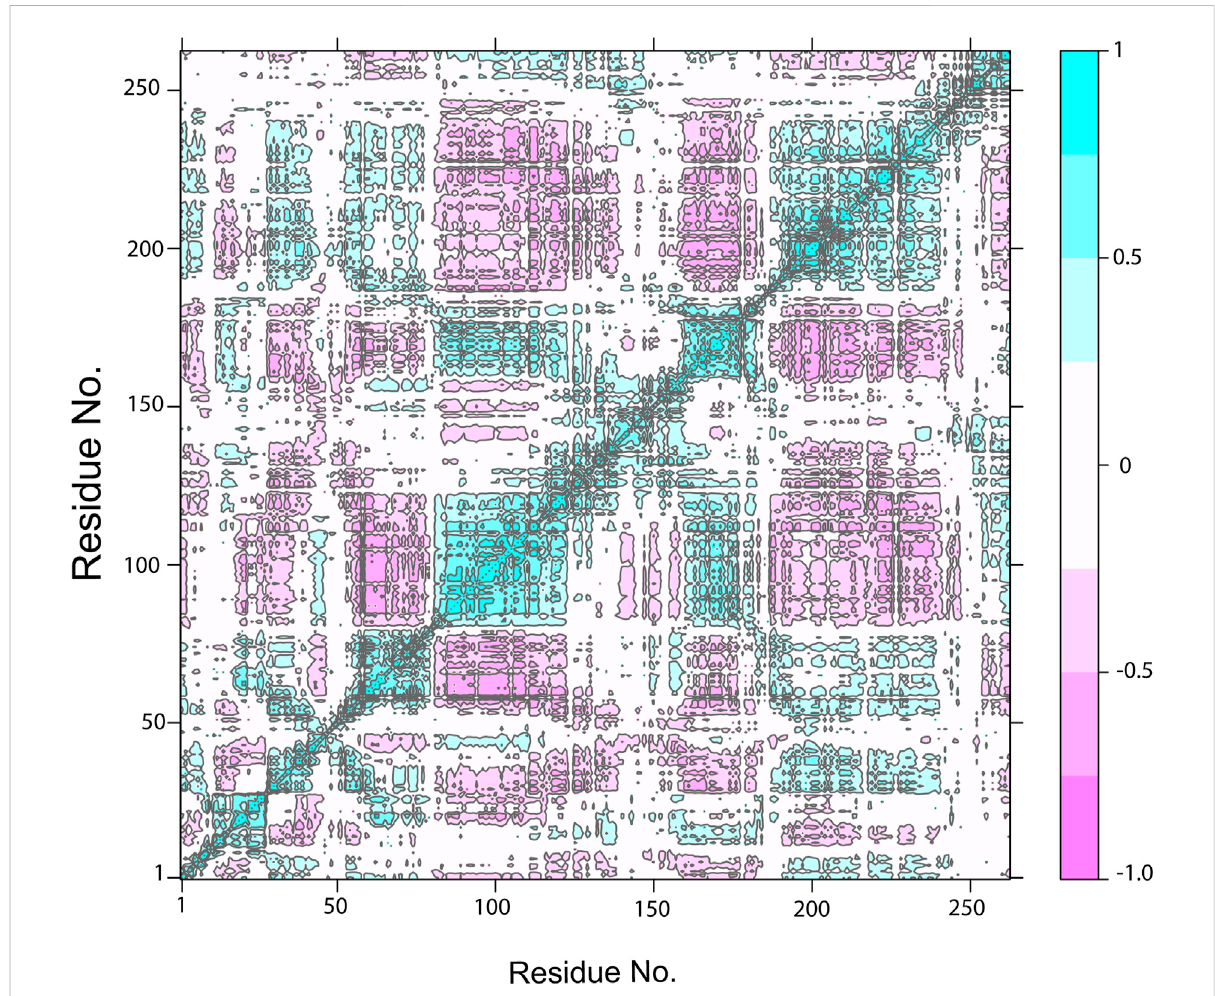
FIGURE 11 The Dynamic Cross-Correlation map of TTK-NDC1 complex. The positive and negative correlation among the residues is shown by cyan and purple color, respectively.